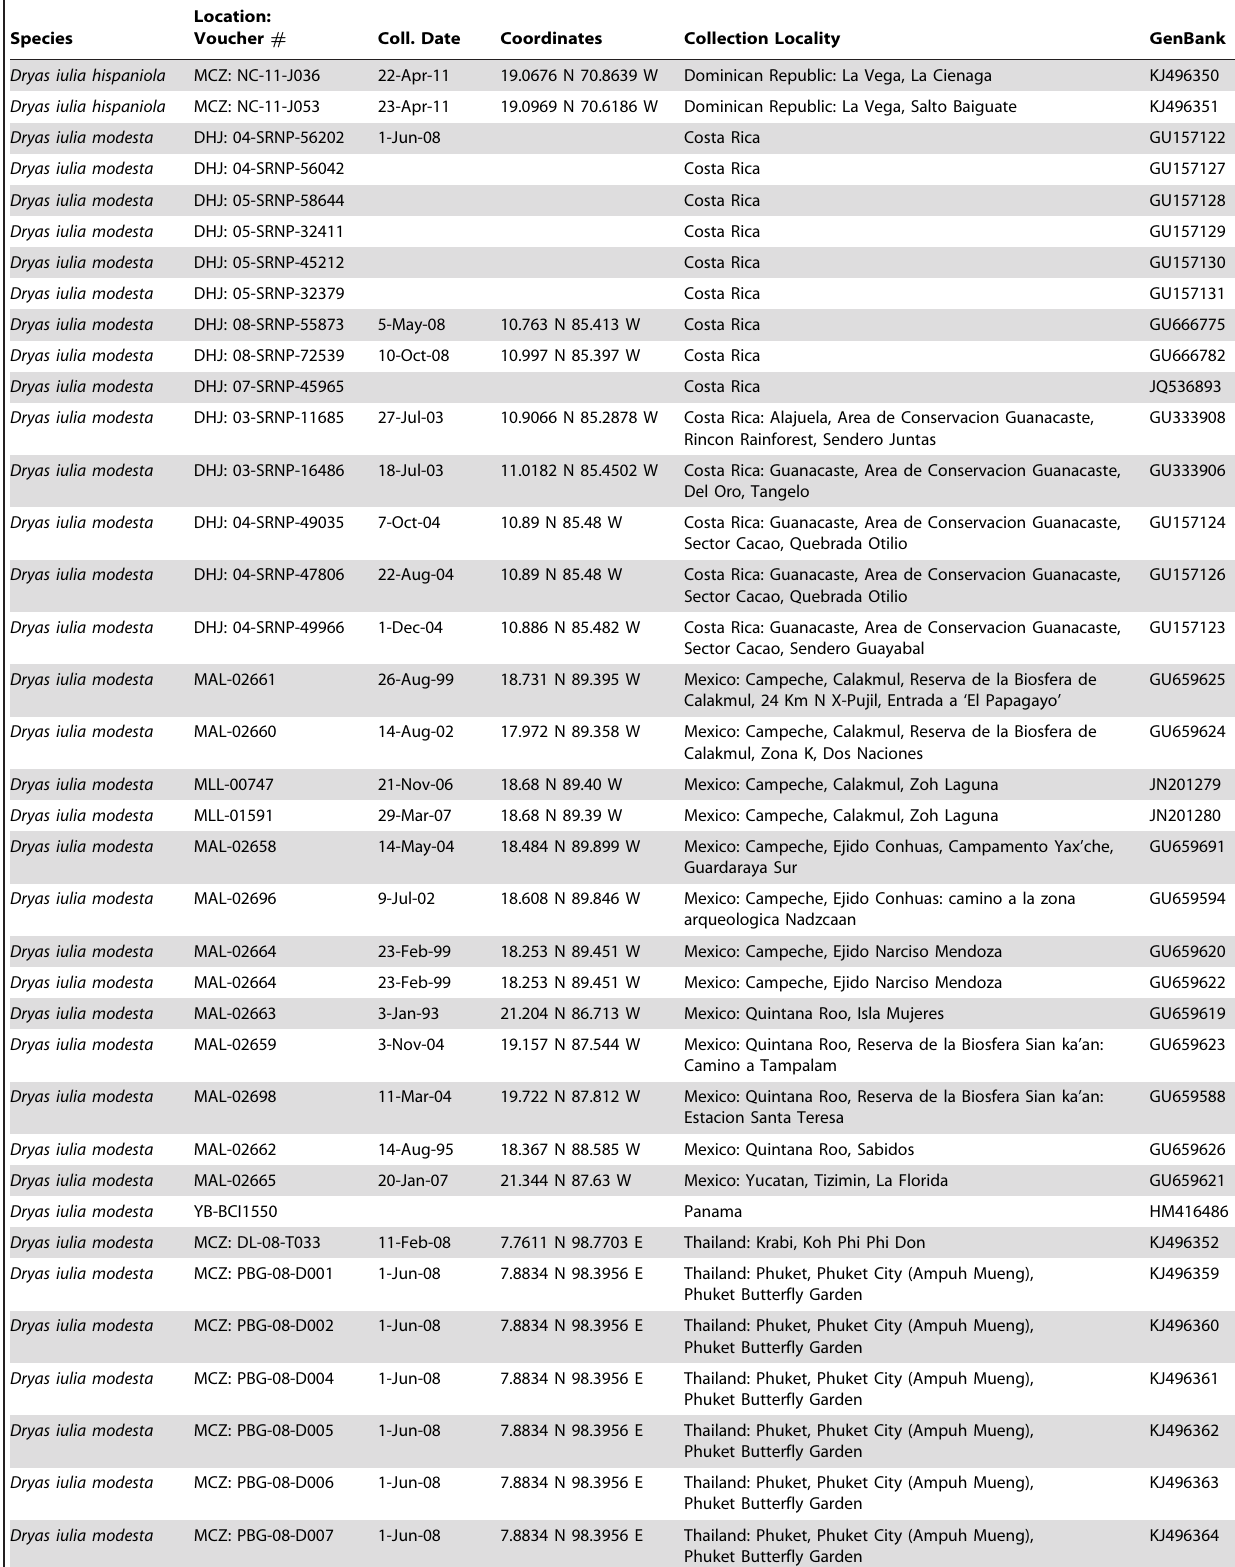
Location: Species Voucher # Coll. Date Coordinates Collection Locality